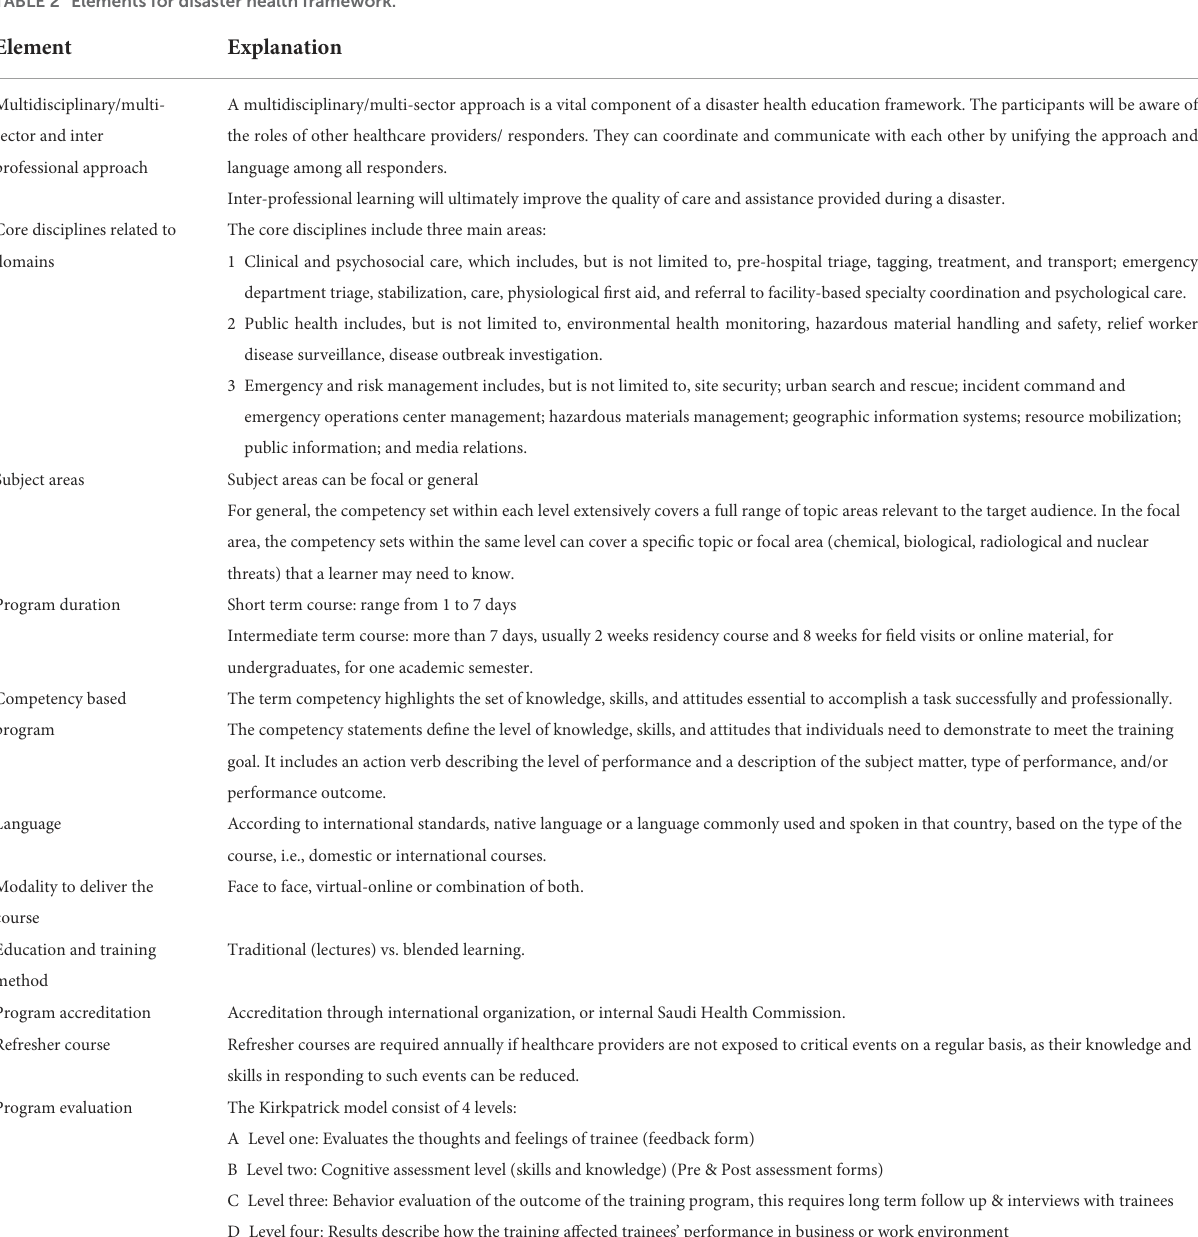
TABLE 2 Elements for disaster health framework.